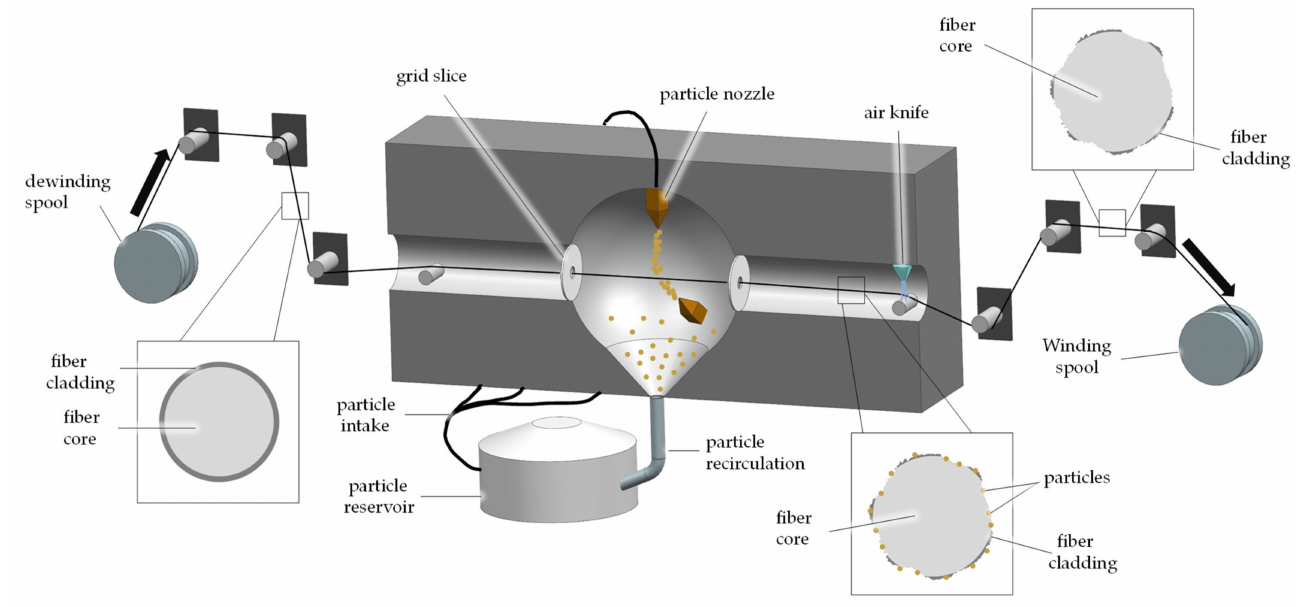
Figure 7. Continuous abrasive sidelight activation of a single POF by particle